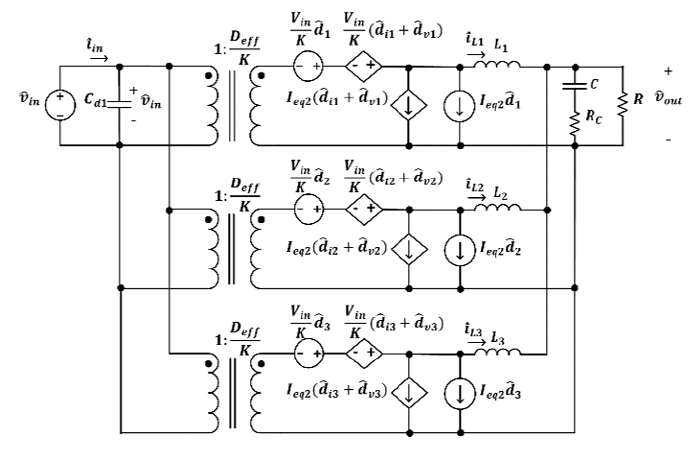
Figure 4. IPOP DC-DC converter SSM.